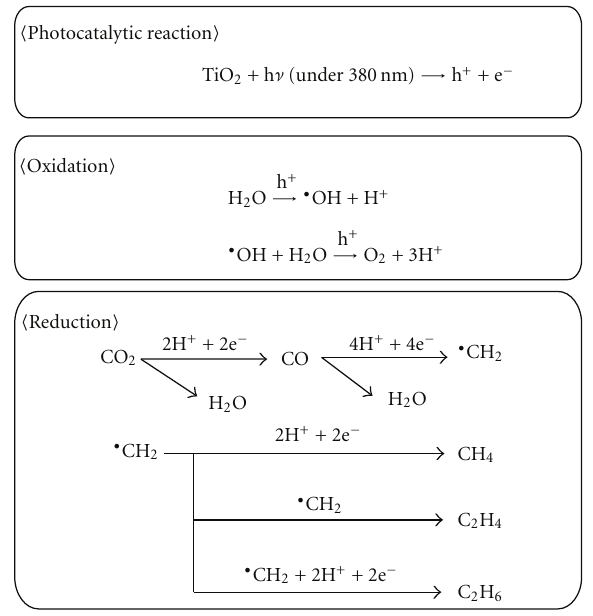
Figure 1: Reaction scheme of CO 2 reforming into fuel by TiO 2 photocatalyst ( (cid:129) OH: hydroxy radical, (cid:129) CH 2 : carbon radical).